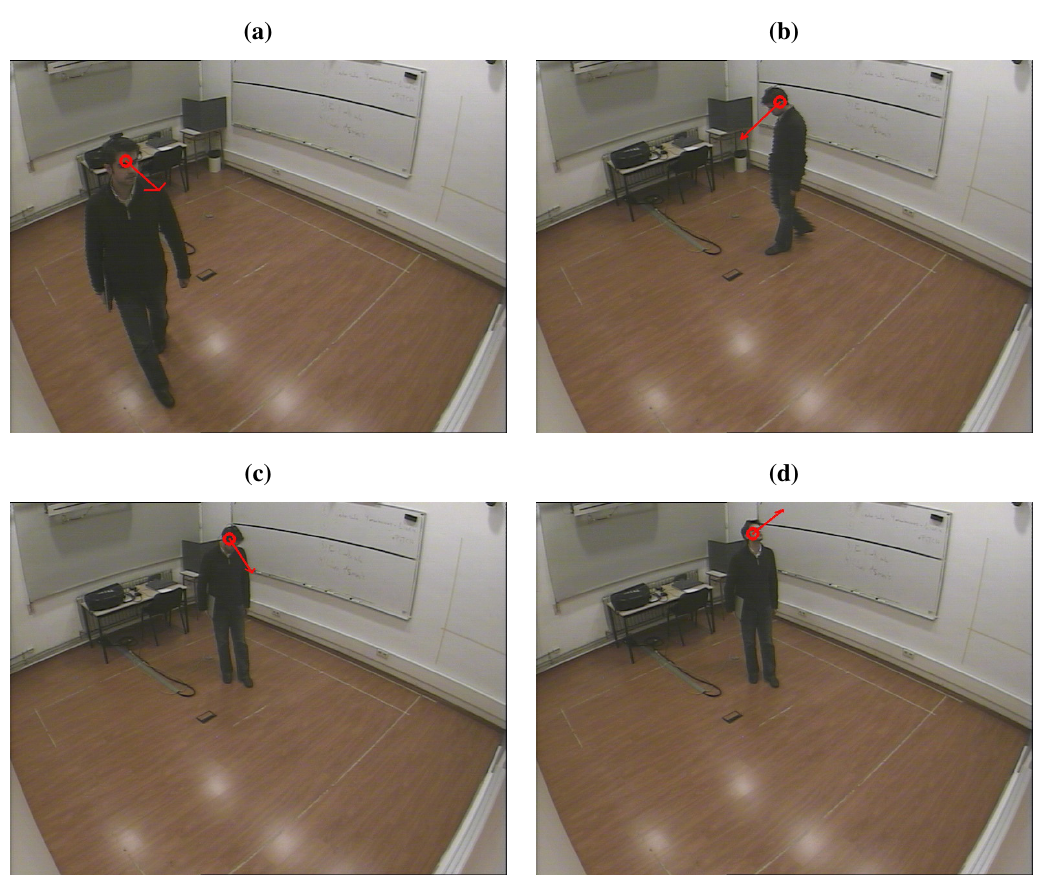
Figure 3. Single person dataset snapshots, with superposed head position and rotation